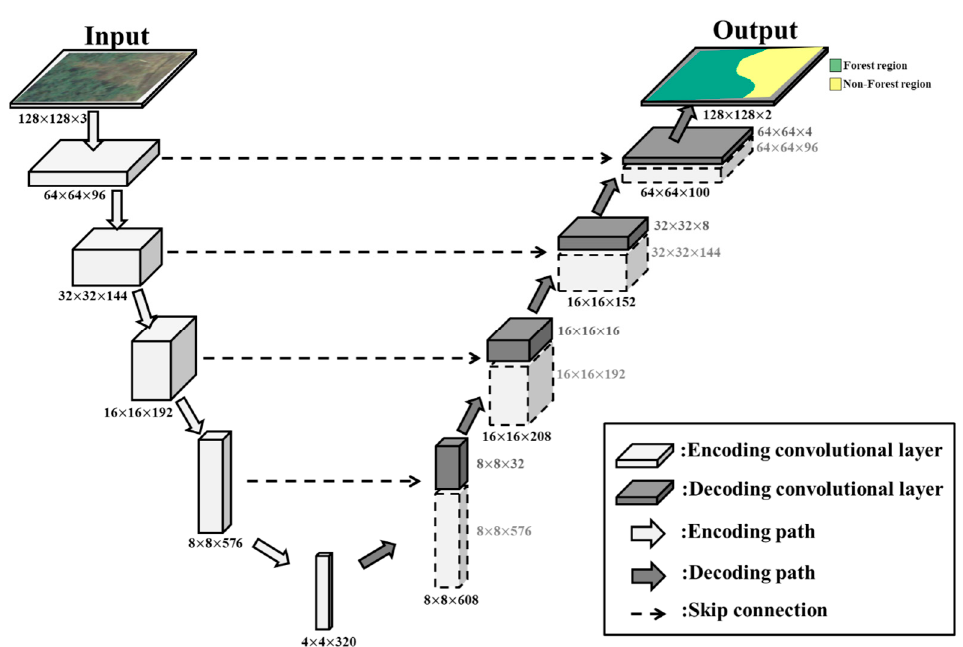
Figure 2. U-Net structure for semantic segmentation from the airborne images classifying forest and non-forest regions. Encoding layers were adopted pre-trained structure of MobileNetV2. In addition, decoding layers were pix2pix architecture where the numbers of internal layers were refined.